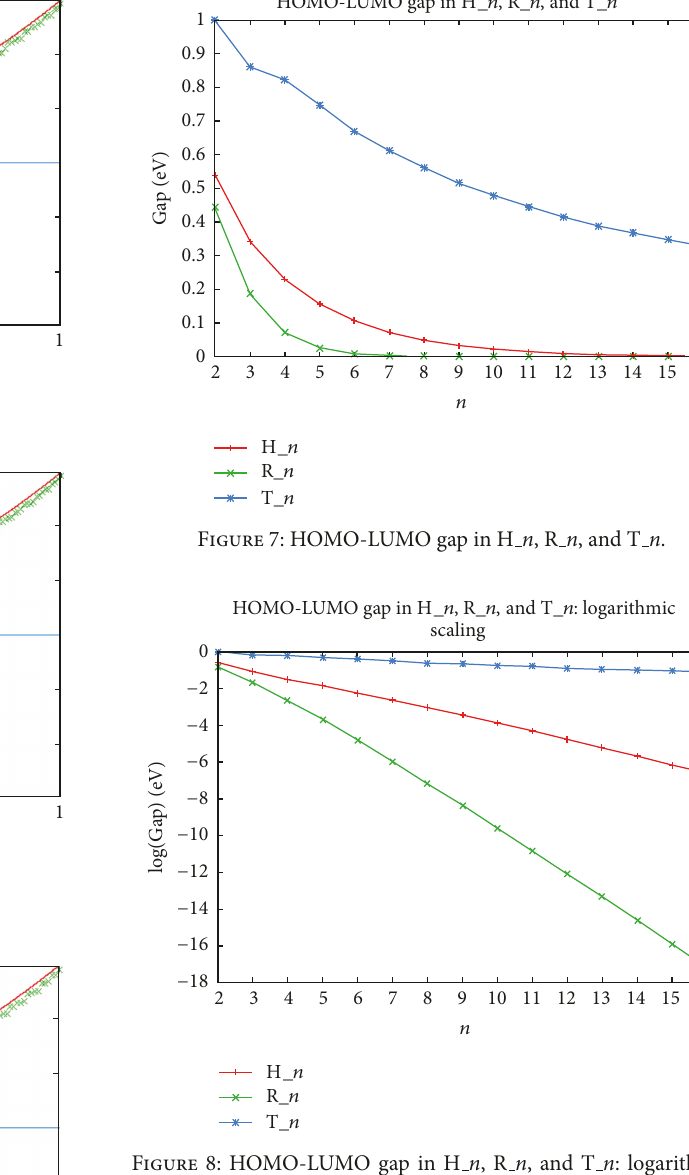
Figure 8: HOMO-LUMO gap in H n , R n , and T n : logarithmic